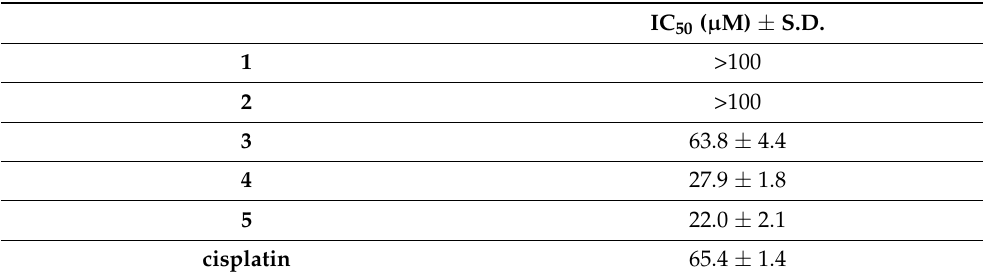
Table 2. Cytotoxicity of ligands 1 and 2 , Ag(I) complexes 3 – 5 and cisplatin toward U1285 cancer cell